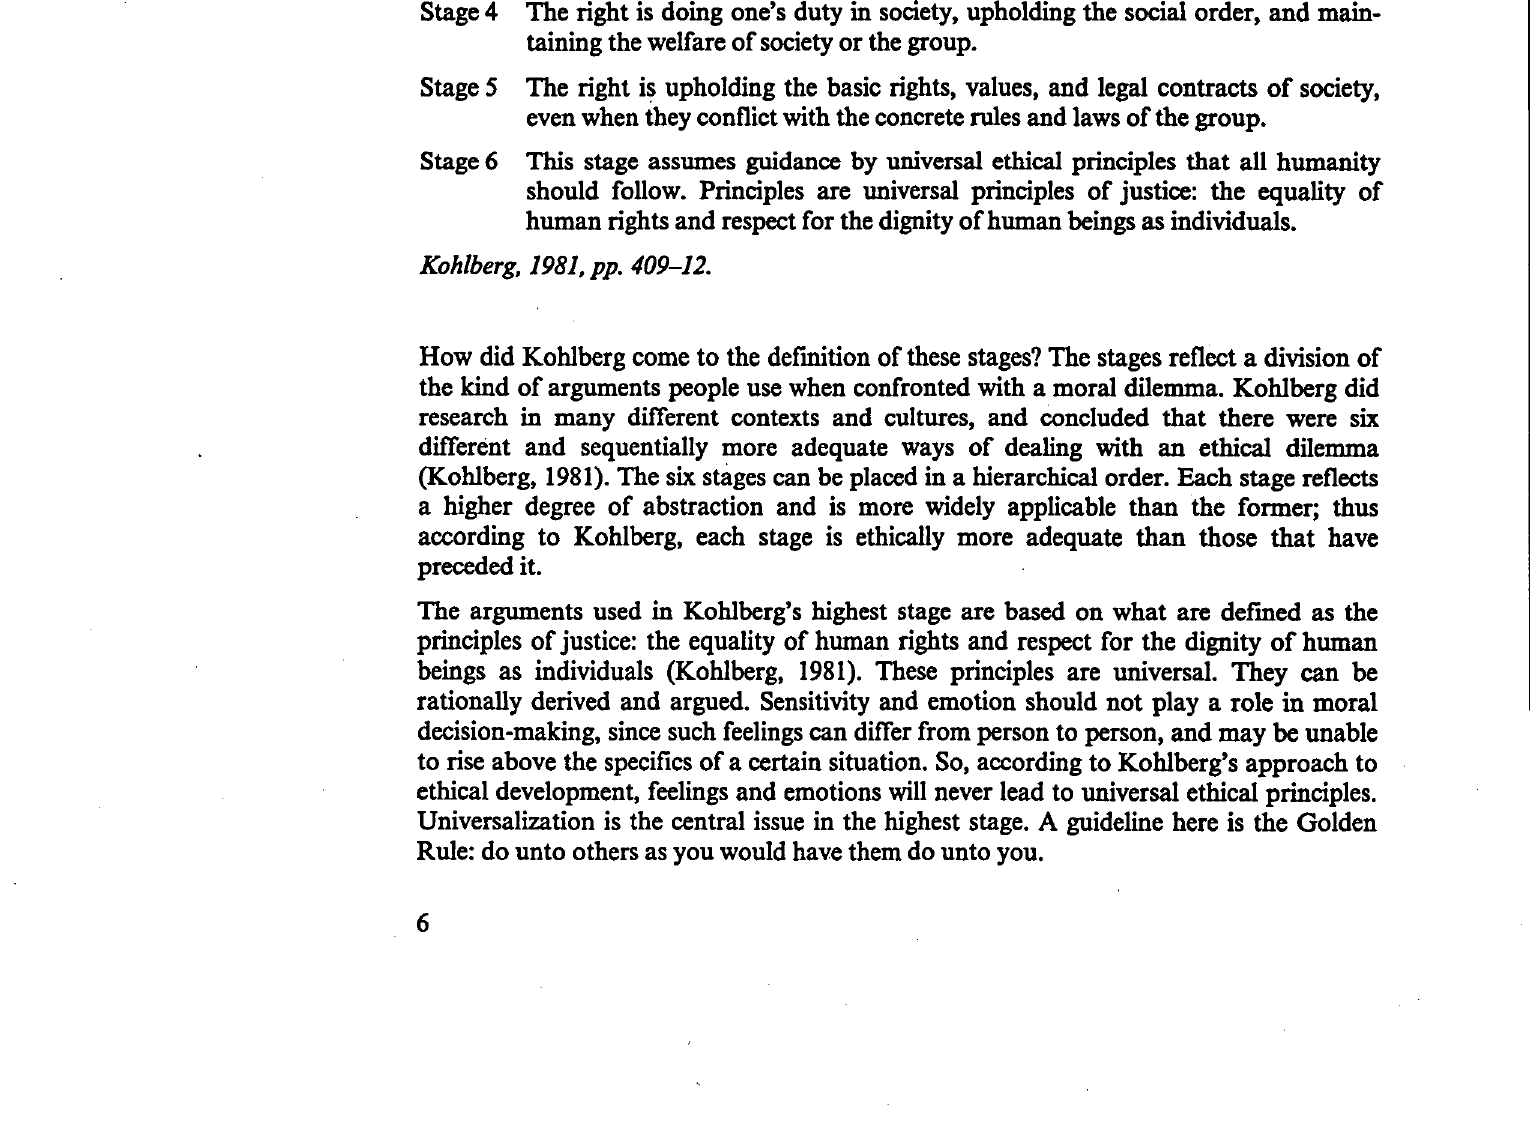
Table 1: Kohlberg's six